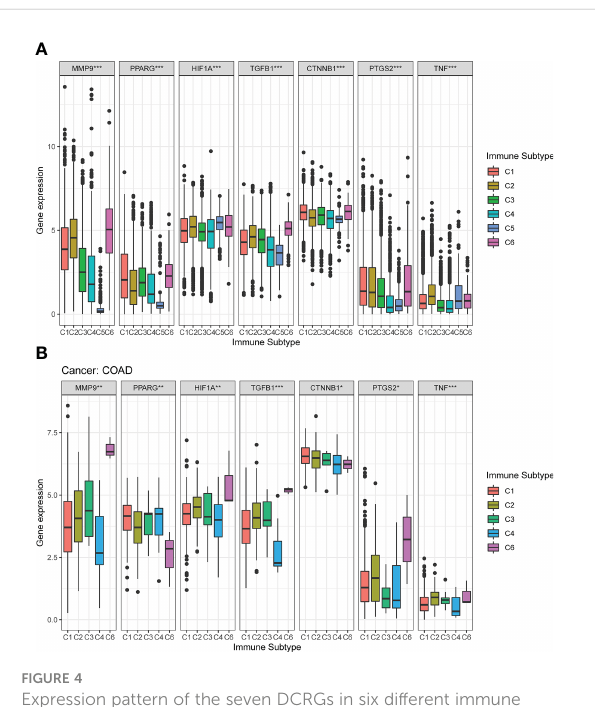
FIGURE 4 Expression pattern of the seven DCRGs in six different immune subtypes. (A) Transcriptional expression of the seven DCRGs in C1- C6 immune subtypes across all TCGA cancers. (B) Box plots showing the expression level of the DCRGs in the immune subtypes in COAD ( ∗∗∗ P < 0.001; ∗∗ P < 0.01; ∗ P < 0.05).